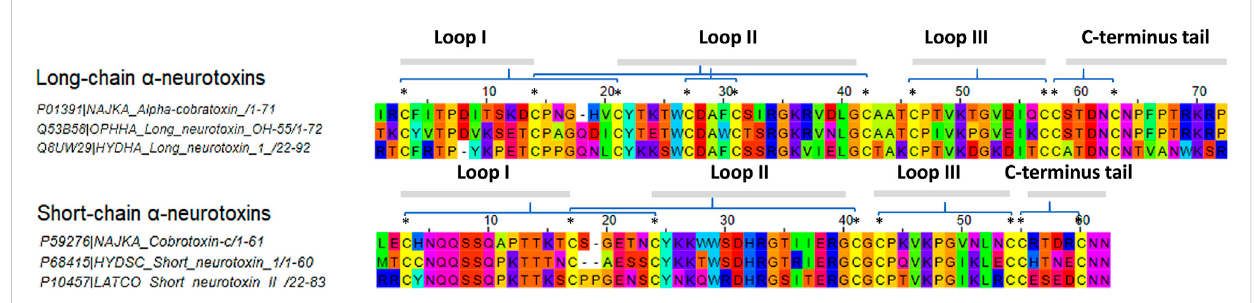
FIGURE 1 Multiple sequence alignment of selected elapids long-chain and short-chain alpha-neurotoxins. Sequences were acquired from the UniProt database. Abbreviations: NAJKA , Naja kaouthia ; OPHHA , Ophiophagus hannah ; LATCO , Laticauda colubrina ; HYDSC , Hydrophis schistosus ; HYDHA , Hydrophis curtus . Asterisk symbols indicate the location of disul fi de